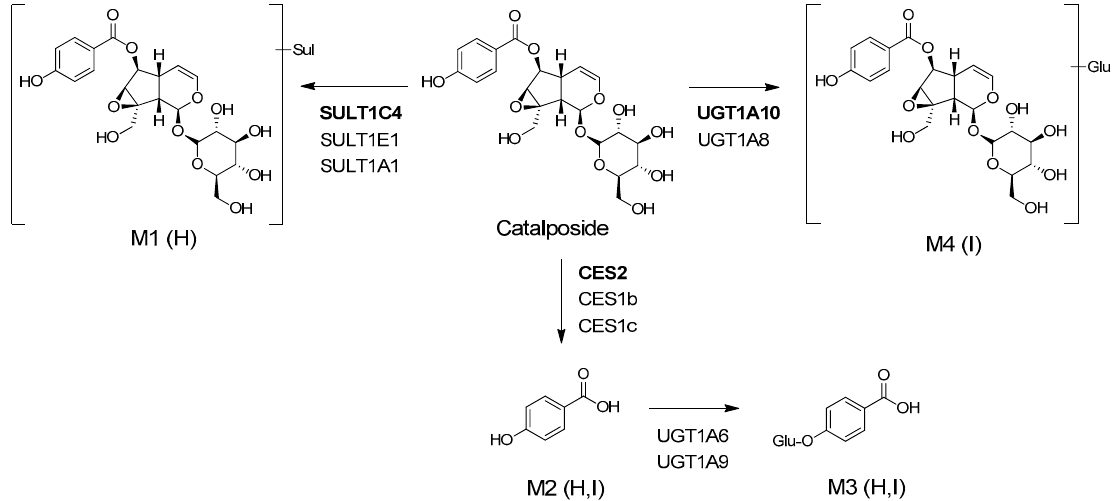
Figure 3. Possible in vitro metabolic pathways of catalposide incubated with human hepatocytes and intestinal microsomes. H: human hepatocytes; I: human intestinal microsomes; Sul: sulfate; Glu: glucuronic acid; CES: carboxylesterase; UGT: UDP-glucuronosyltransferase; SULT: sulfotransferase.